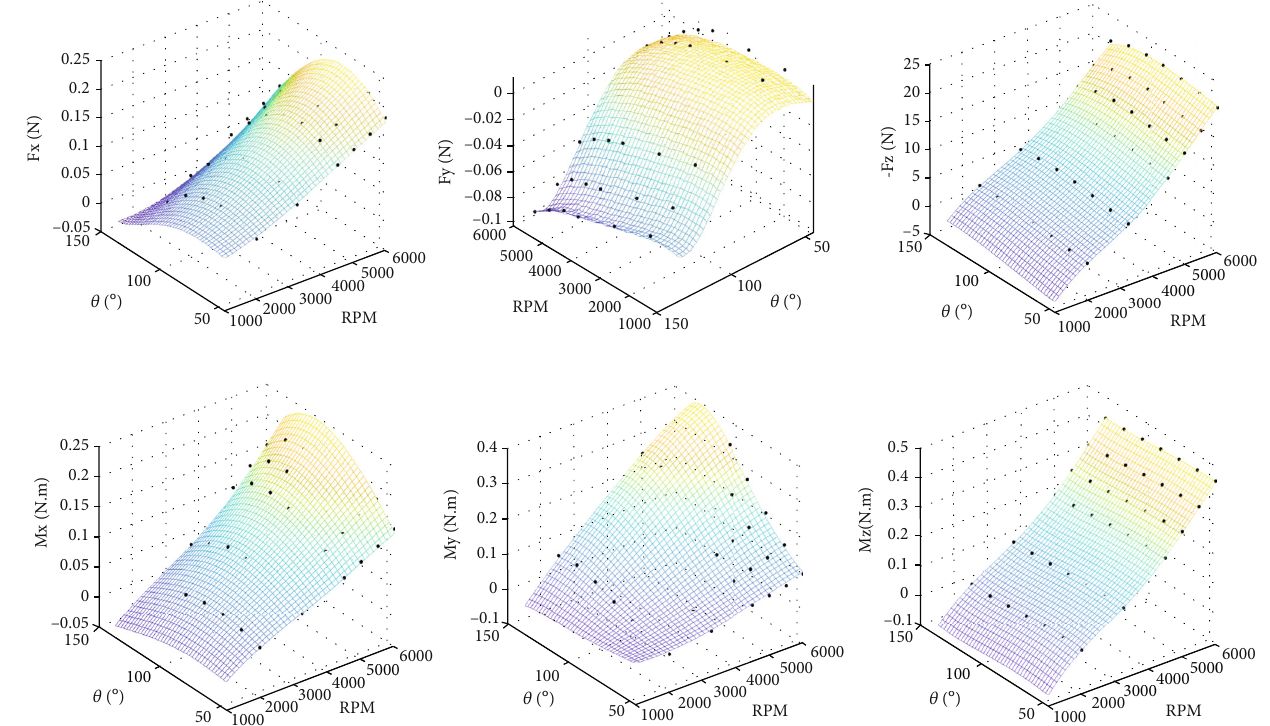
Figure 5: 16 × 5 : 4 rotor model at 4 m/s wind, where black dots denote sample points of the CFD results at 4 m/s